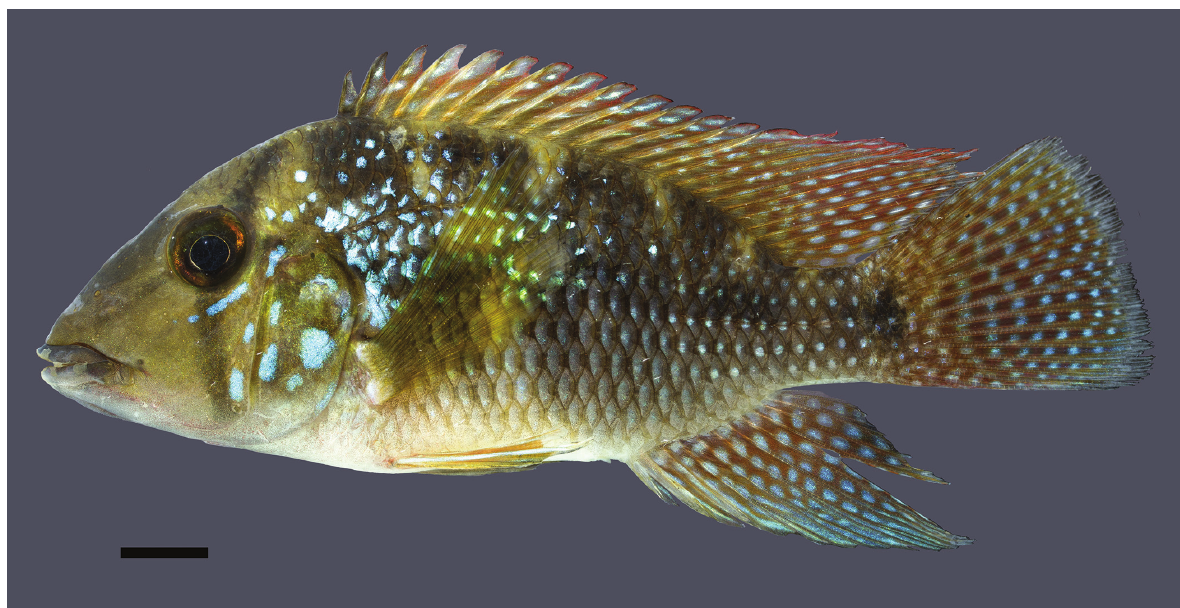
Figure 2. Geophagus rufomarginatus , UFRJ 9994, holotype, 96.8 mm SL; Brazil: Bahia: Rio Buranhém Basin. Scale bar 10 mm. Photograph by J.L.O.